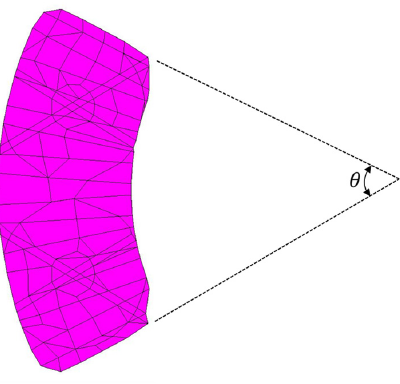
Figure 10. Configuration of brake pad for shape angle 𝜃 .